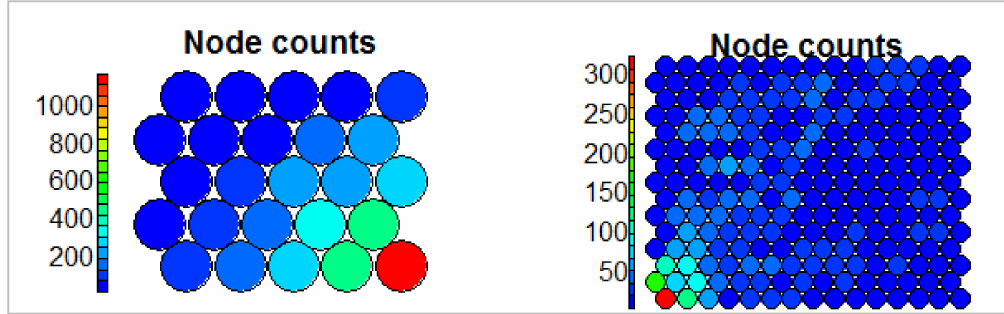
Figure 11. Clustering considering a 5 × 5 and 15 × 15 alternative maps.